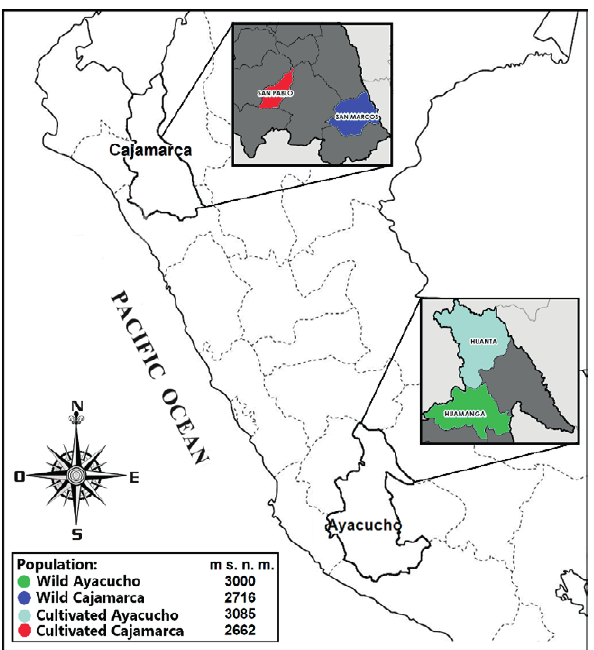
Figure 1. Map of Peru showing sampling locations for wild and cul- tivated populations of Physalis peruviana